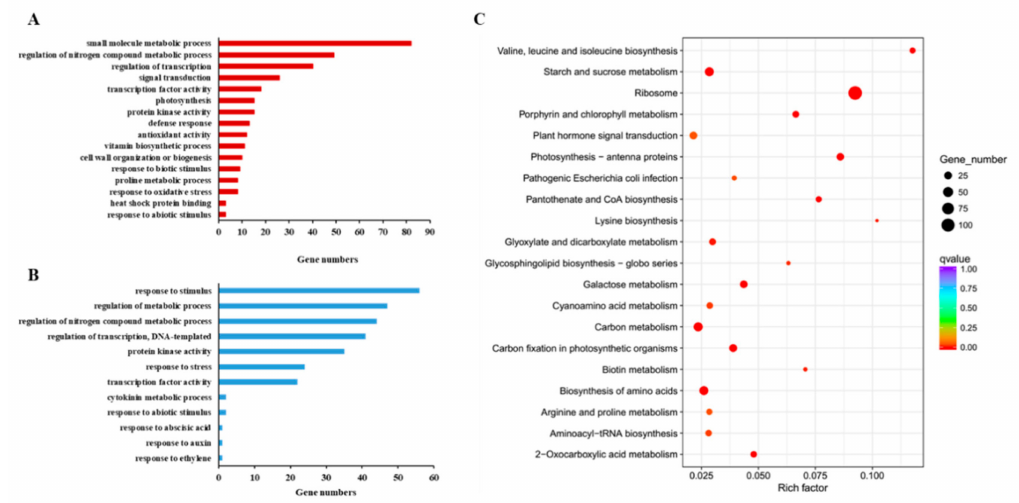
Figure6. Geneontologydatabase(GO)andkyotoencyclopaediaofgenesandgenomesdatabase(KEGG) classifications of di ff erentially expressed genes (DEGs). ( A ) GO analysis of the upregulated genes in CTS vs. mock. ( B ) GO analysis of the downregulated genes in CTS vs. mock. ( C ) KEGG classifications of all genes between the without and with 3 d of CTS pre-treatment in annual ryegrass plants.